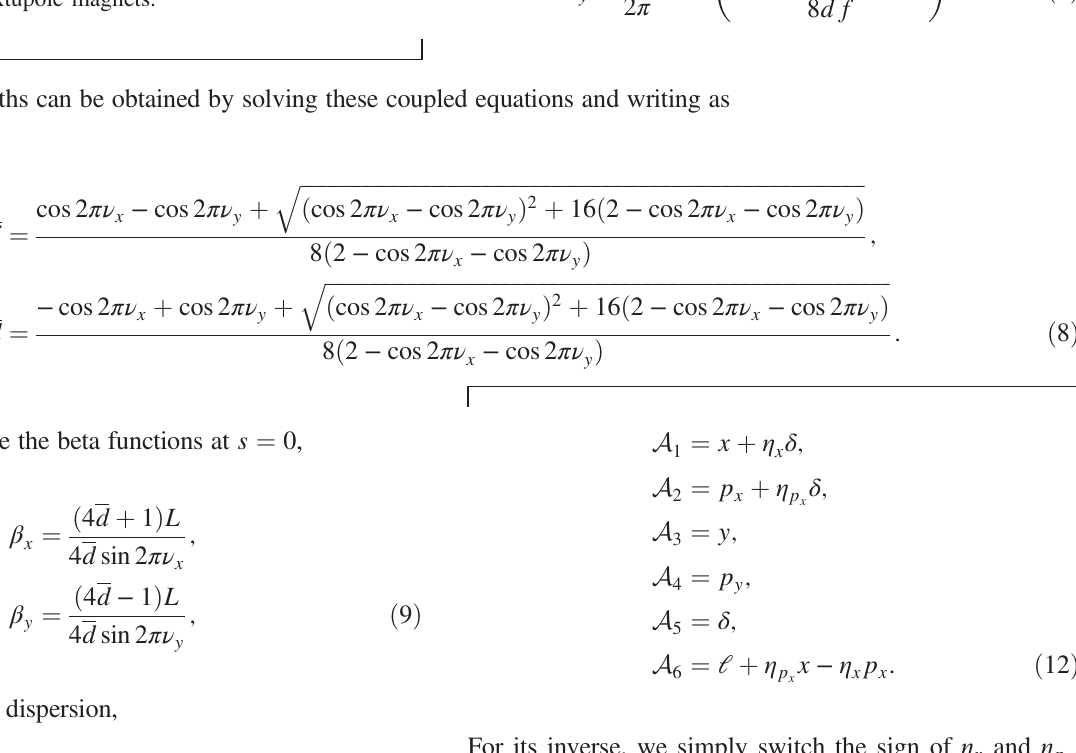
FIG. 1. A periodic focusing and defocusing cell with dipole, quadrupole, and sextupole